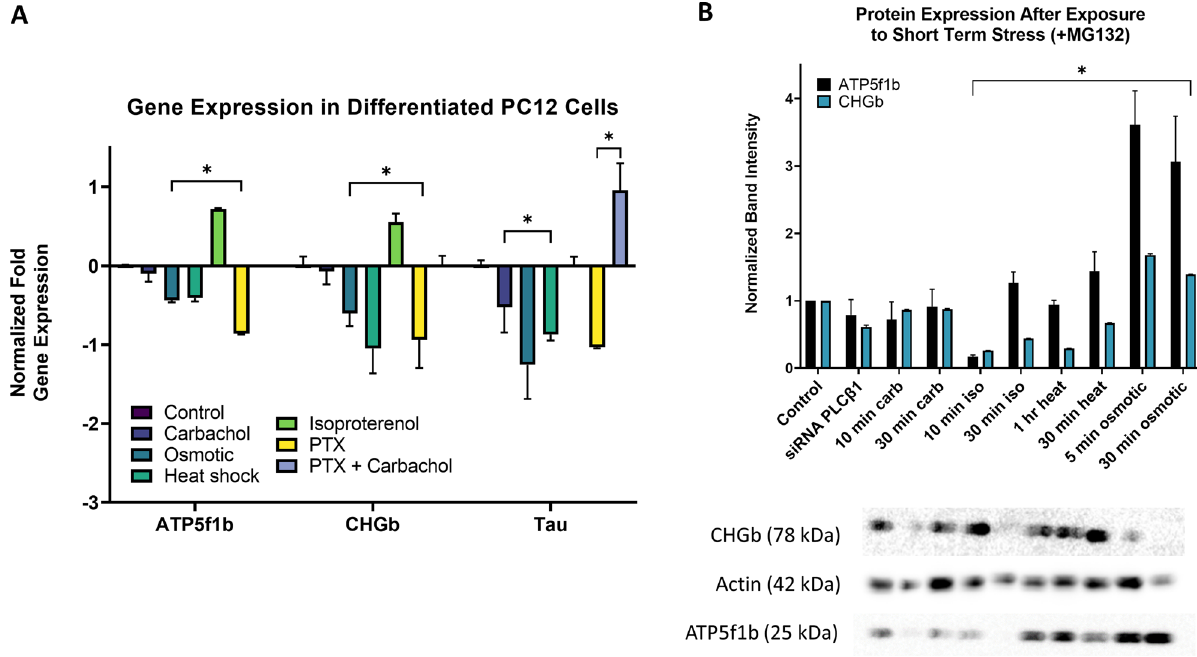
Figure 3. Gene expression and protein levels of ATP5f1b and CHGb in cells under stress. ( A ) RT-PCR results showing the relative levels of gene expression in PC12 cells of ATP5f1b, Chgb and tau (as a negative control) in differentiated PC12 cells exposed to different stress conditions (carbachol stimulation, hypo-osmotic stress, heat shock, isoproterenol as a Gαi stimulant and pertussis toxin (PTX) to eliminate effects of Gαi), where * denotes p ≤ 0.001 and n = 3–9 and SE is shown. ( B ) PC12 cells, either untransfected or treated with siRNA(PLCβ1) for 48 h, were stimulated with carbachol or isoproterenol for Gαq or Gαi activation, respectively, or subjected